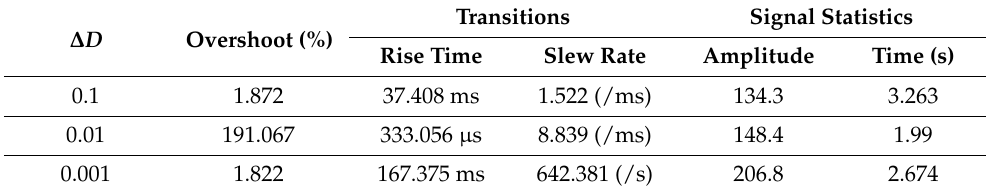
Table 6. Power Analysis at variable ∆ D for PV System.